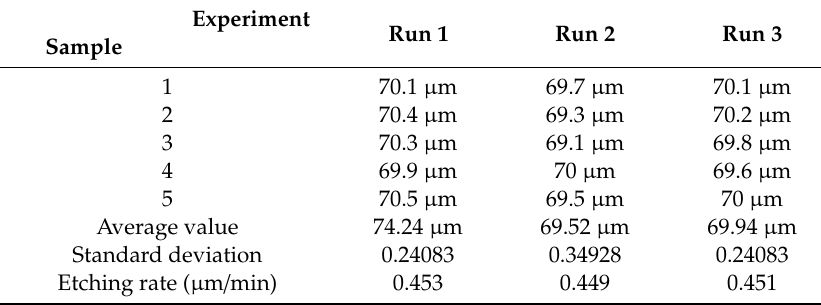
Table 3. Statistical results of three repeated